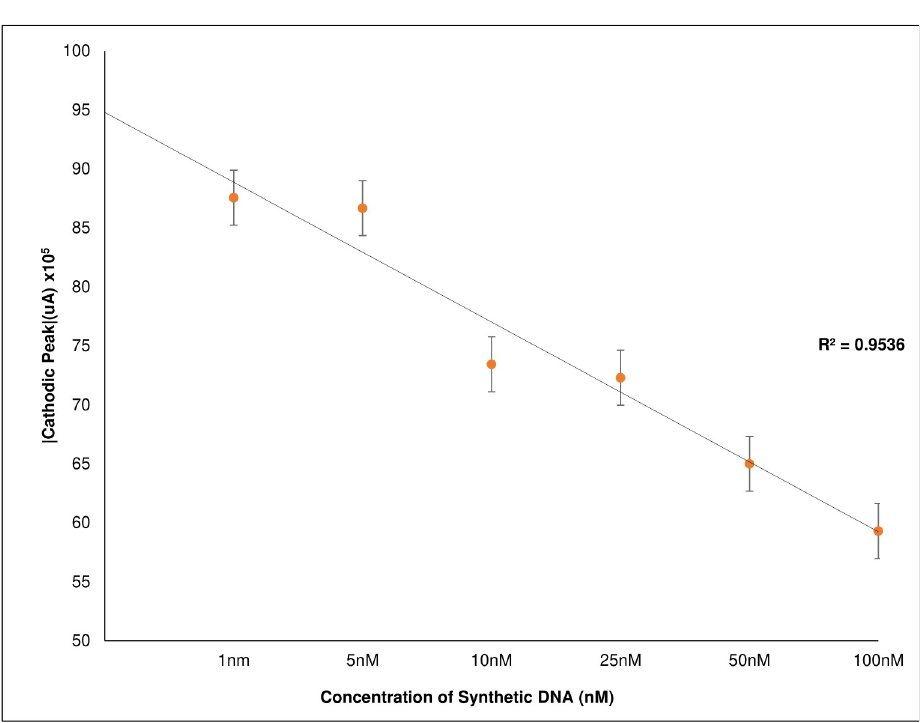
Fig 6. Sensor calibration curve using the absolute value of cathodic current peak versus target DNA concentration in range 1nM to 100nM, showing a lineal trend.